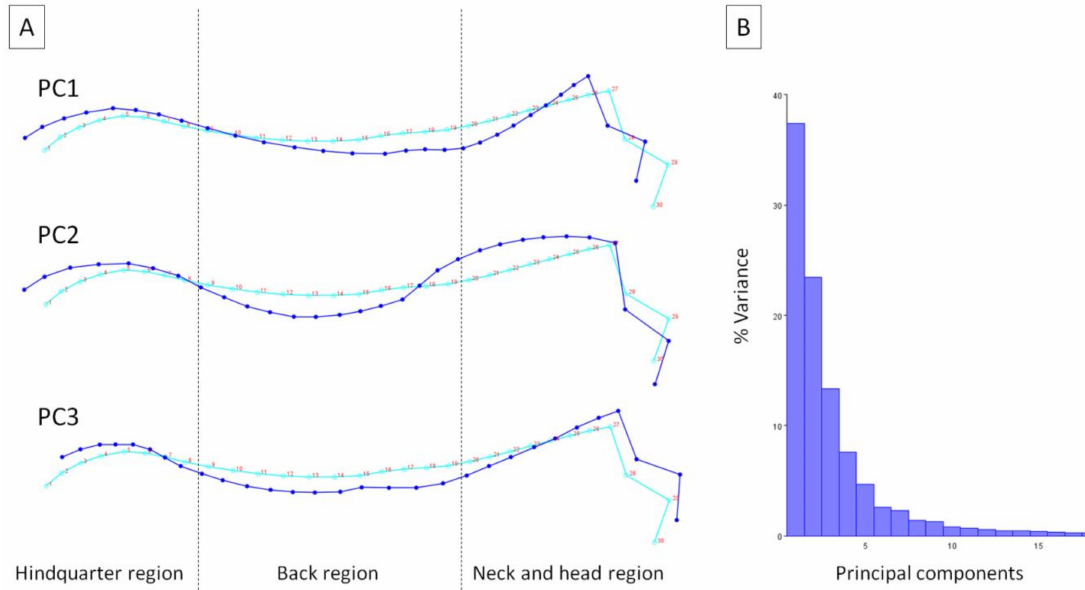
Figure 4. Principal components of the dorsal profiles of donkeys, represented by ( A ) the wireframe graph and ( B ) the histogram of variance. Light blue landmarks and curves represent the consensus donkey’s dorsal profile. Dark blue landmarks and curves represent the extremum (minimum of the axis) of PC1, PC2, and PC3, respectively. Dashed lines indicate the boundaries between regions. Consecutive landmarks are marked with increasing numbers from the first caudalis vertebra (1) to the tuber faciale